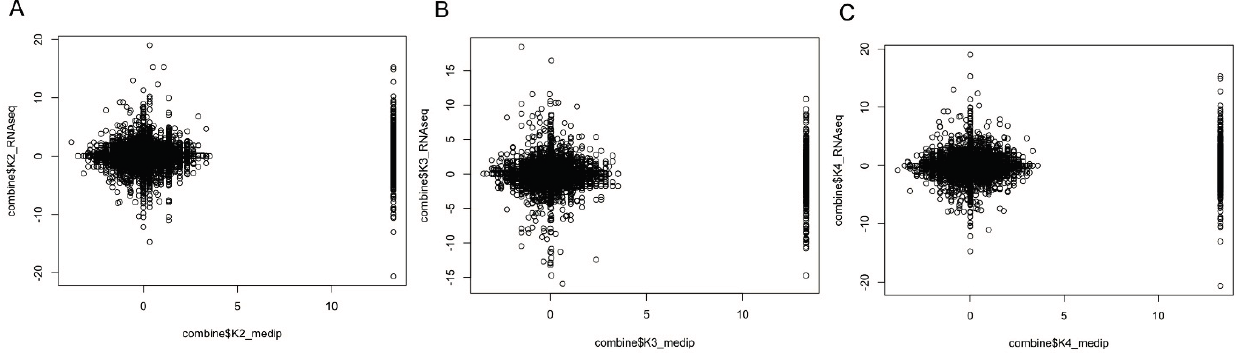
Figure 5. Relationship between DNA methylation in the proximal promoter regions and gene expression level in maize roots responsive to Pb stress for K2 ( A ); K3 ( B ); and K4 ( C ). Genes were assessed according to differential expression levels. DNA methylation level was measured by the log ratio of the p value of the methylation peaks, with each point representing the mean expression level and the relative methylation